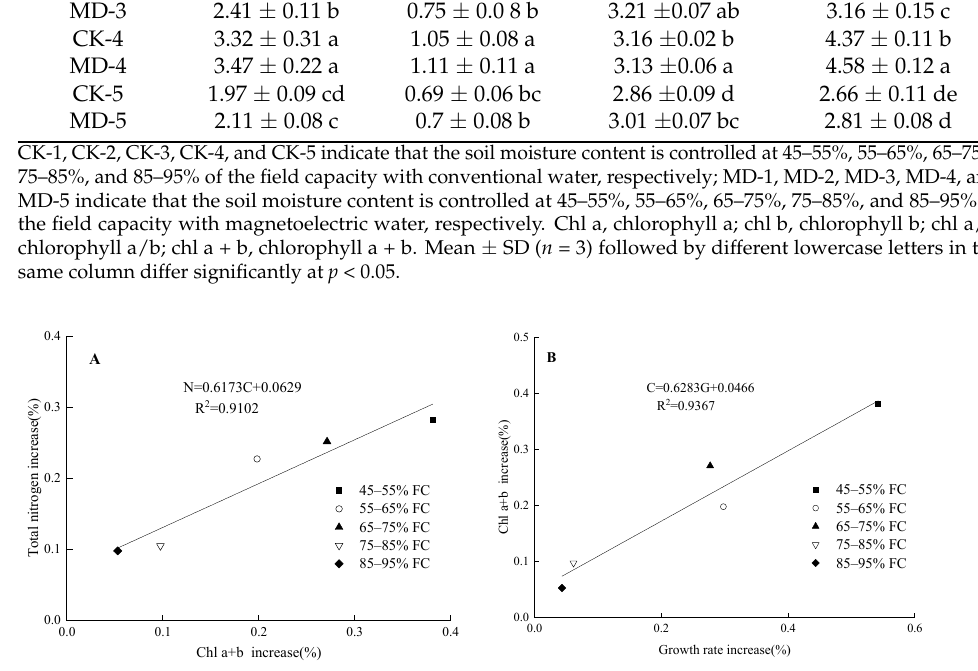
Figure 4. The increase in chlorophyll was related to the increase in total nitrogen amount ( A ) and growth rate ( B ), respectively. N, leaf total nitrogen; C, chlorophyll a + b increase; G, growth rate increase; FC, field capacity.